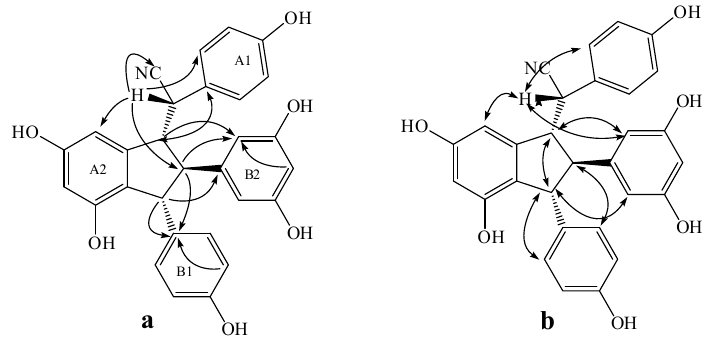
Figure 5. The key HMBC ( a ) and NOESY ( b ) correlations of 6 .